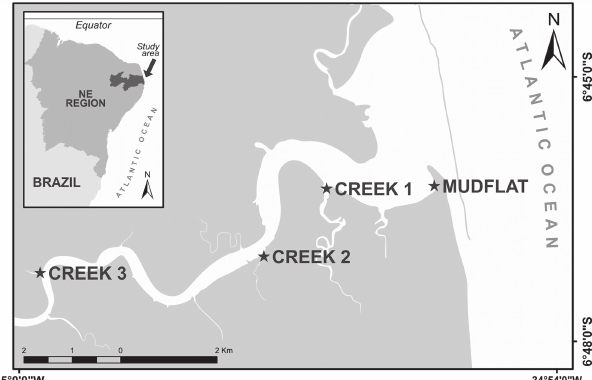
Fig. 1 . Map of the study area with locations of the sampling sites in the rio Mamanguape Estuary, Brazil: 1- Mud flat; 2- Tidal Creek 1; 3- Tidal Creek 2; 4- Tidal Creek